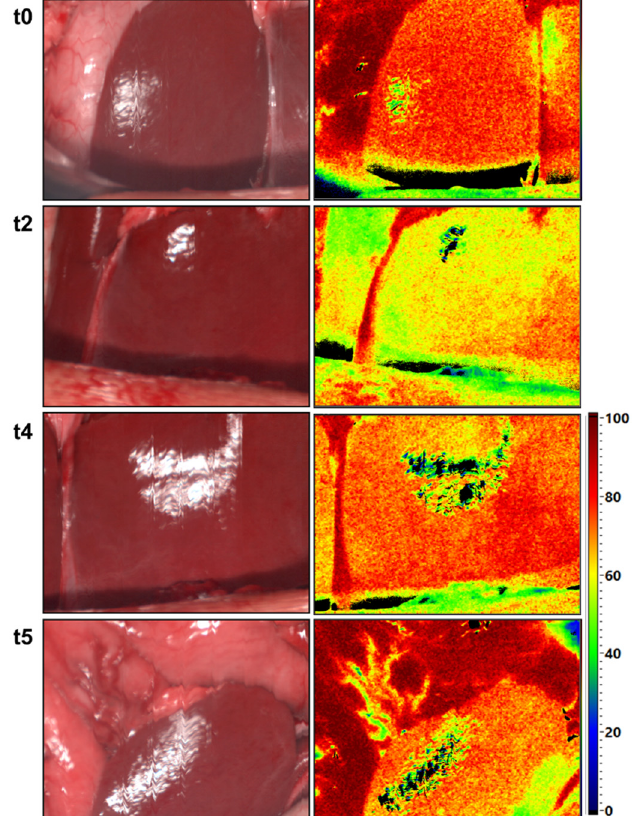
Figure 8. Color images (left) and color-coded images of the tissue oxygenation in % (right) of the liver from patient 3 with CAS Type B. t0 : before GDA clamping, t2 : 15 min after GDA